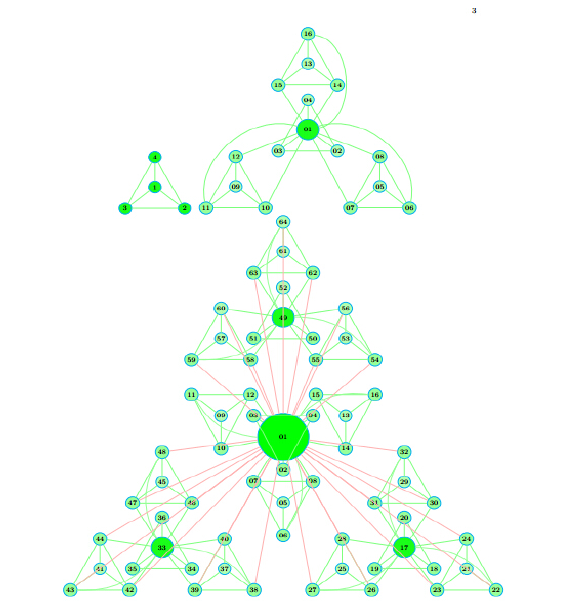
Figure 2: Construction of the deterministic scale-free network, showing the first four steps of the iterative process. Number 01 is the centre Hub or node and Number 17,33,49 are sub node which combine the first level Hub of all 64 nodes.